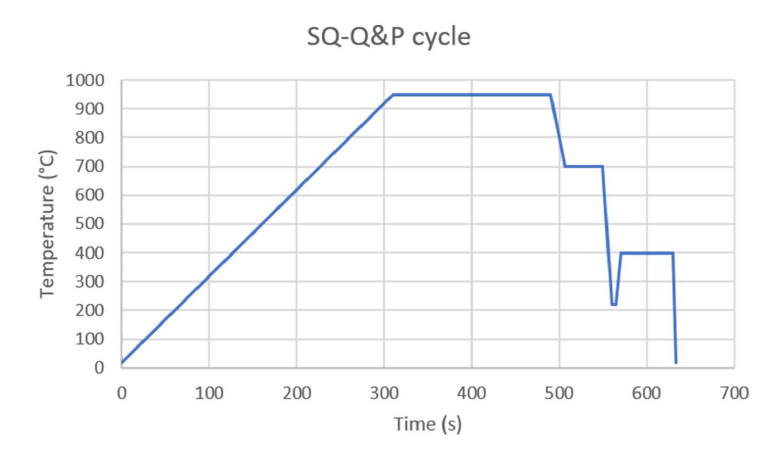
Figure 9. Schematic SQ heat cycle design followed by Q&P process. Table 5. Final phase fractions predicted by the CCE and CCET models after the combination of SQ and Q&P cycles, with different Step times and QT temperatures. RA f γ , ' a f